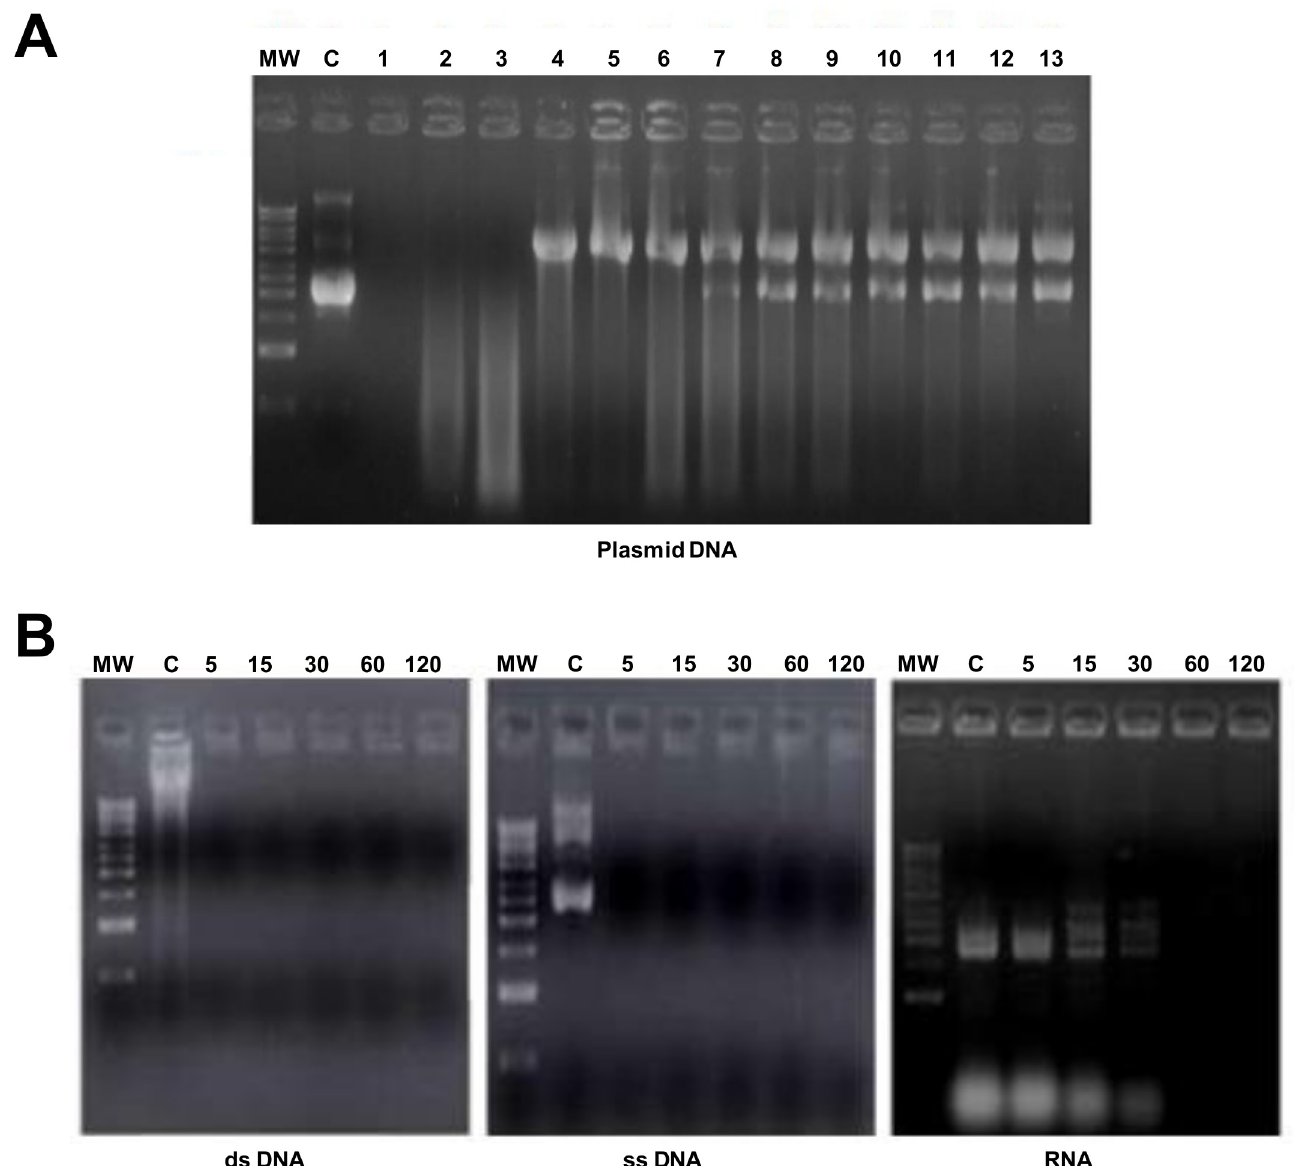
Fig 4. Nuclease activity of Mycoplasma meleagridis . (A) Nuclease activity associated with intact M . meleagridis cell suspensions against plasmid pCR2.1 DNA. Lane MW, 1 kb DNA ladder (Amersham); lane C, untreated plasmid DNA control; lanes 1 – 13, plasmid pCR2.1 DNA incubated with two-fold serial dilutions of M . meleagridis cells, containing 1.25 μ g to 0.0003 μ g of total cell protein. (B) Nuclease activity of M . meleagridis against various nucleic acid substrates. The three panels from the left to the right show the effect of M . meleagridis cells on Vero cell double-stranded DNA, M13 phage single-stranded DNA, and E . coli strain BL21 total RNA. Molecular weight markers (1 kb DNA ladder, Amersham) are shown on the left of each panel. Lane C was loaded with undigested nucleic acid (incubated with buffer alone). M . meleagridis cell suspensions (containing 1.25 μ g total cell protein) were incubated with nucleic acid substrates at 37°C for different period times (indicated in minutes above each